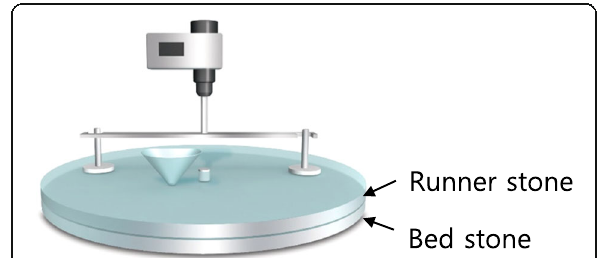
Fig. 1 Schematic drawing of millstone for exfoliation of